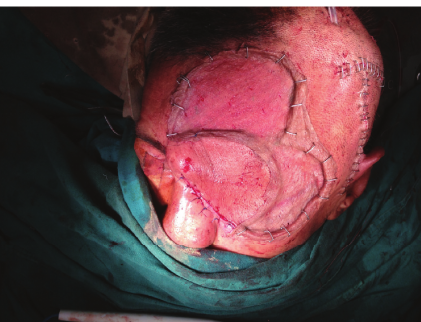
Figure 3: Clinical photograph showing postoperative status following extended exenteration and myocutaneous flap transposition from forehead and temporal region to cover the wound defect and left